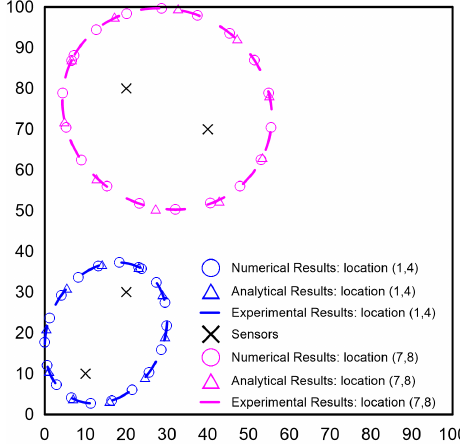
Figure 11. Validation of the analytical approach